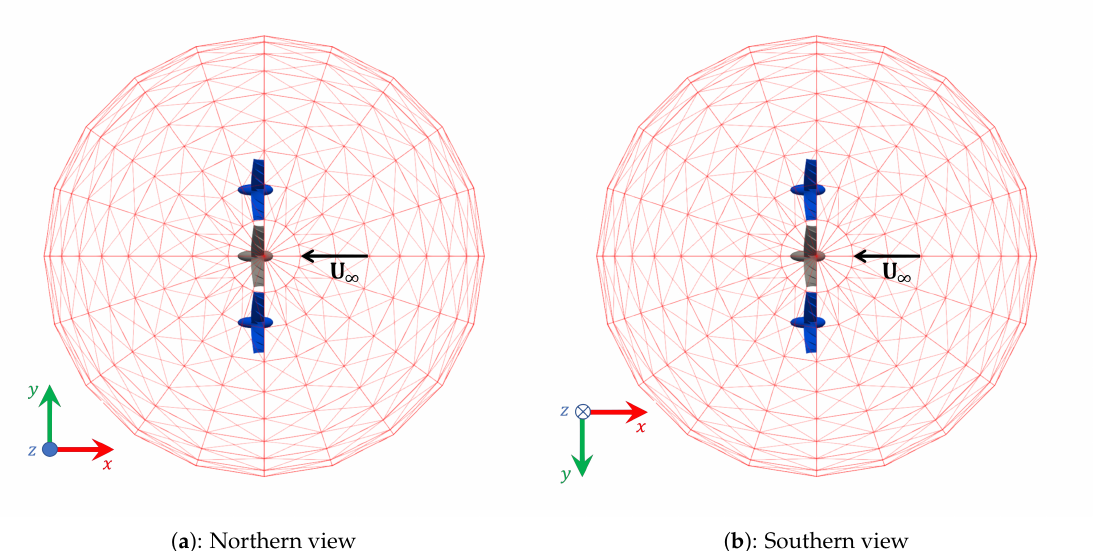
Figure 7. Convention used to report the acoustic results on the sphere. The coordinate system is right-handed so that, on the left the Northern view is characterised by the z -axis outgoing whereas on the right the Southern view is characterised by the z -axis incoming.